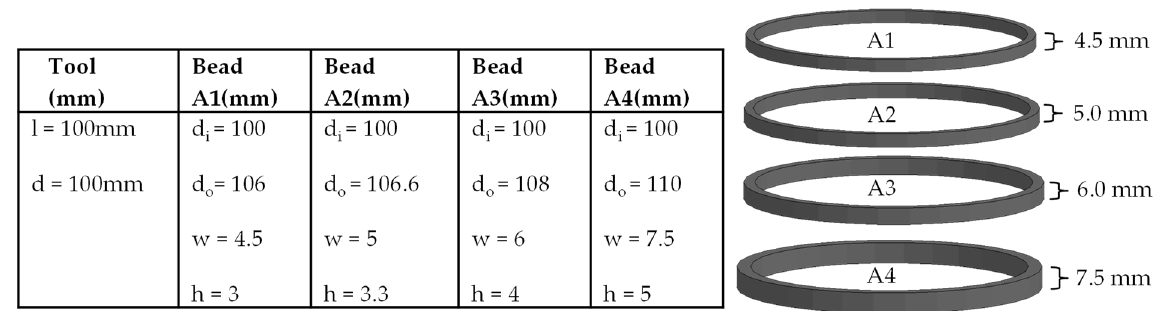
Figure 4. Dimensions, mesh-size, and position of the fixed nodes of the tool (cylinder).